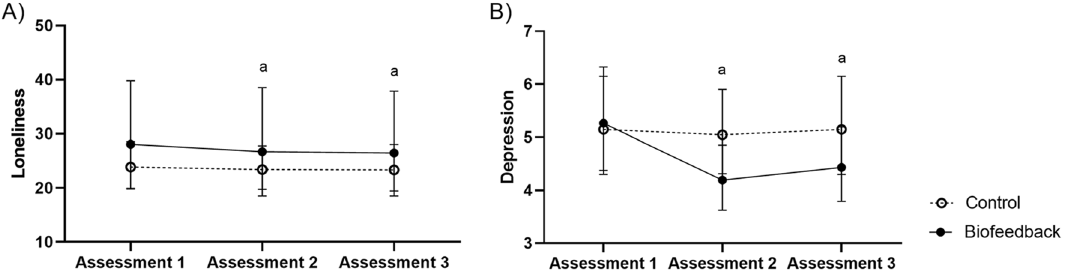
Figure 3. ( A ) Loneliness; ( B ) symptoms of depression. All scales were evaluated in assessments 1, 2, and 3 in the group that received biofeedback training (solid black line) and in the group that received the control training (dotted black line) in the institutionalized sample. a Significant difference of assessment 2 and 3 in comparison to assessment 1 (<